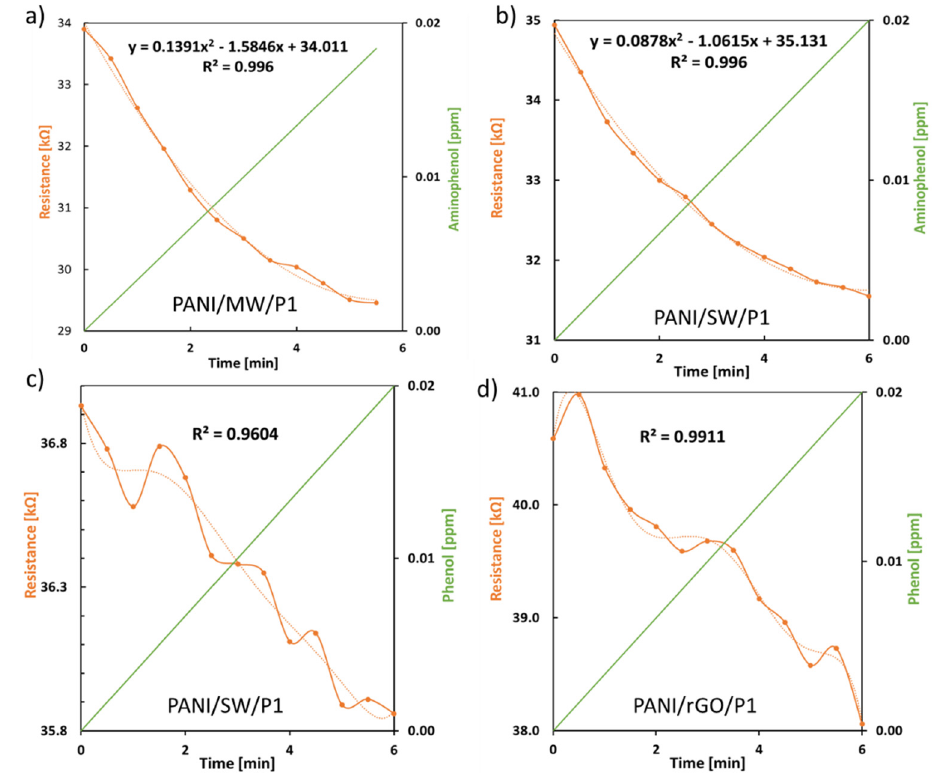
Figure 8. Electrochemical measurements of the sheet resistance of ( a ) PANI/MW/P1, ( b , c ) PANI/SW/P1, and ( d ) PANI/rGO/P1 sensors as a function of the (top) aminophenol and (bottom) phenol concentration.